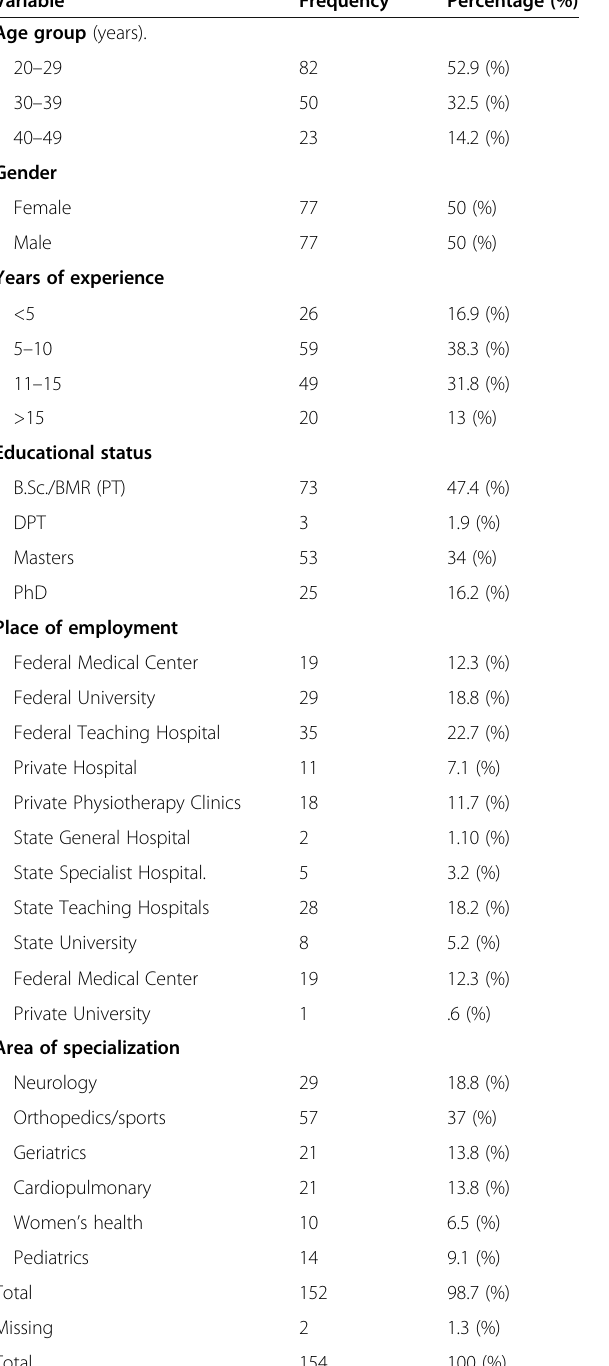
Table 1 The socio-demographic characteristics of the study